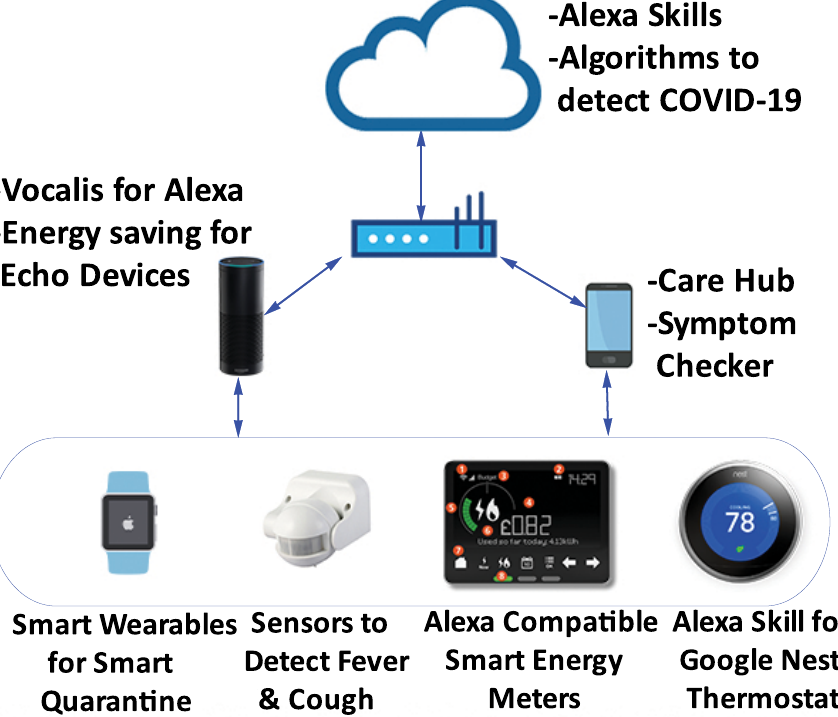
Figure 3. Recent Developments in Smart Homes in the Wake of